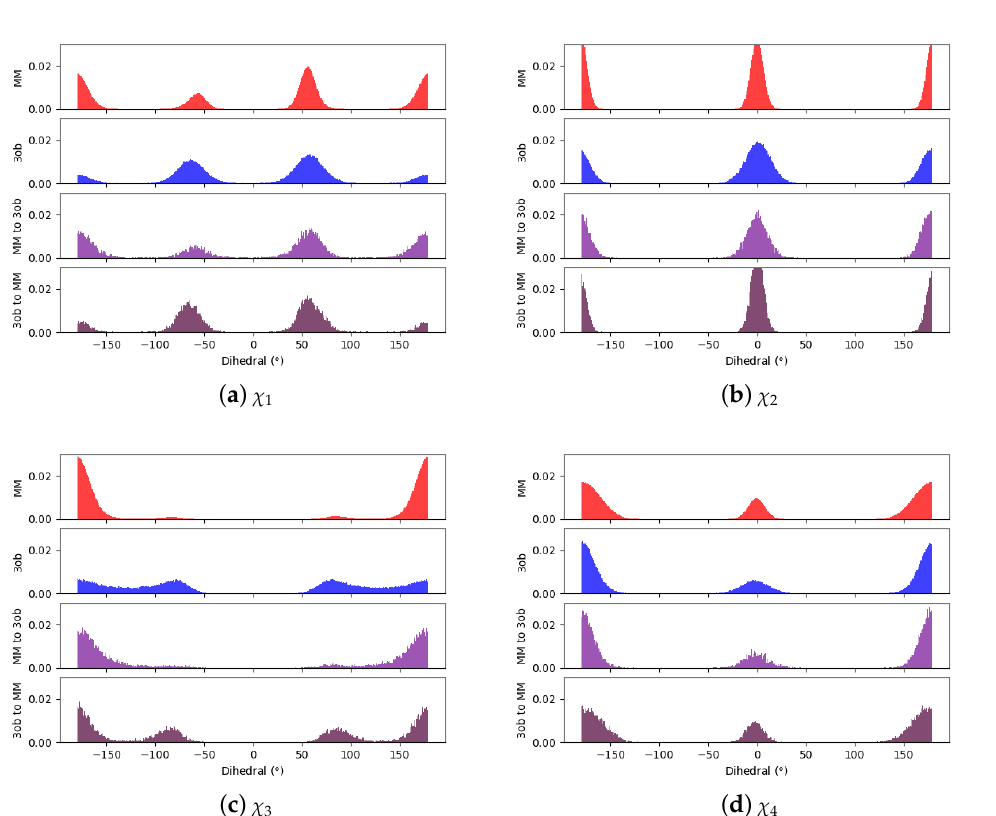
Figure 9. Dihedral populations for 6 ’s dihedral degrees of freedom (see Figure 2 for dihedral